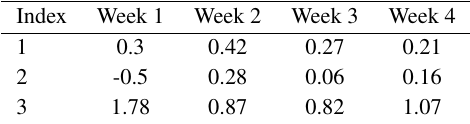
Table 4: A market mispricing measure - Relative Deviation for the three market indices: the sum of prices (index 1), the sum of highest bid prices (index 2) and the sum of lowest ask prices (index 3) in each trading period (week) in Experiment